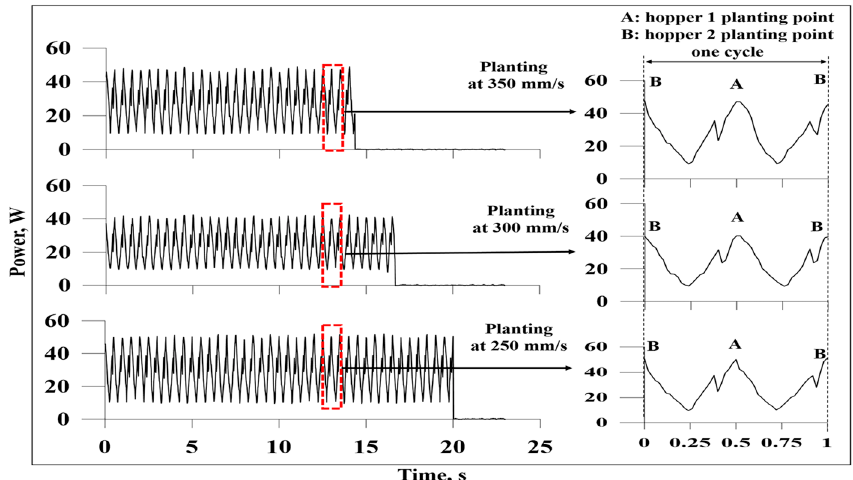
Figure 11. Power consumption of the dibbling mechanism during transplanting operations at different forward speeds.